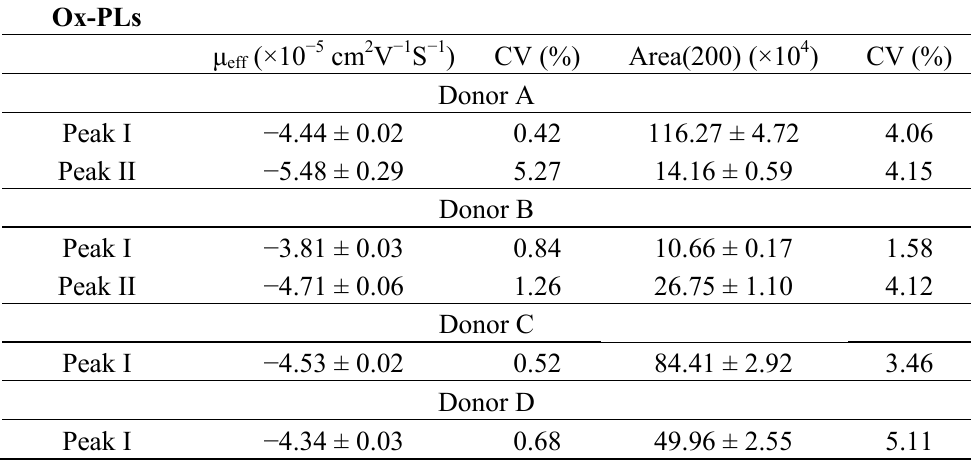
Table 6. The average effective mobility and peak area of in vitro oxidized VLDL phospholipids analyzed by MEKC at absorbance 200 nm (data are means ± SD of four